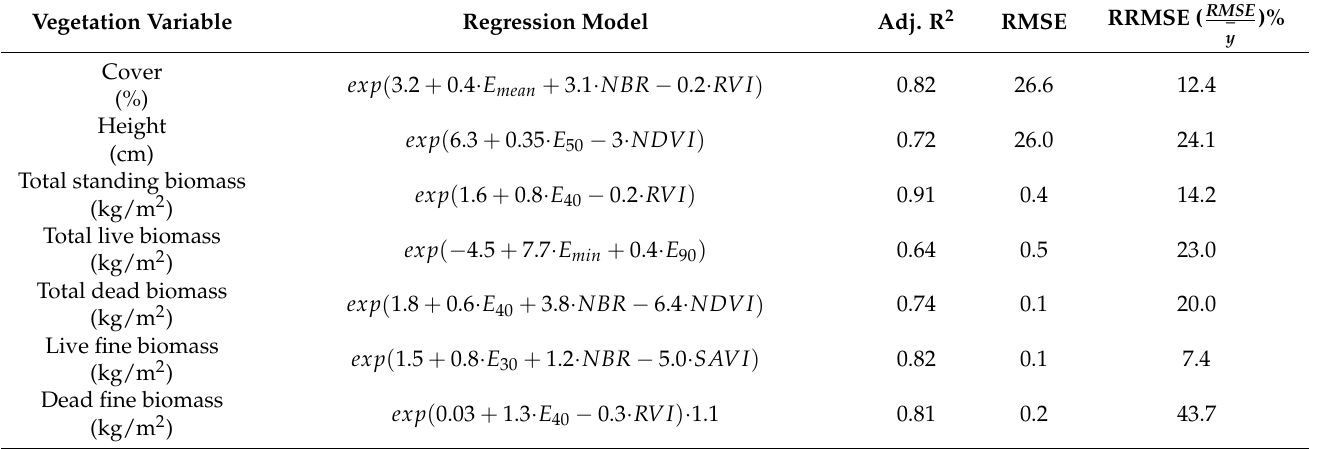
Table 9. Summary of best regression models and the corresponding statistical metrics (Adjusted R 2 , RMSE and RRMSE) determined for each vegetation variable using a combination of LiDAR metrics and Sentinel-2 spectral indices. The RMSE units are the same as those of the dependent